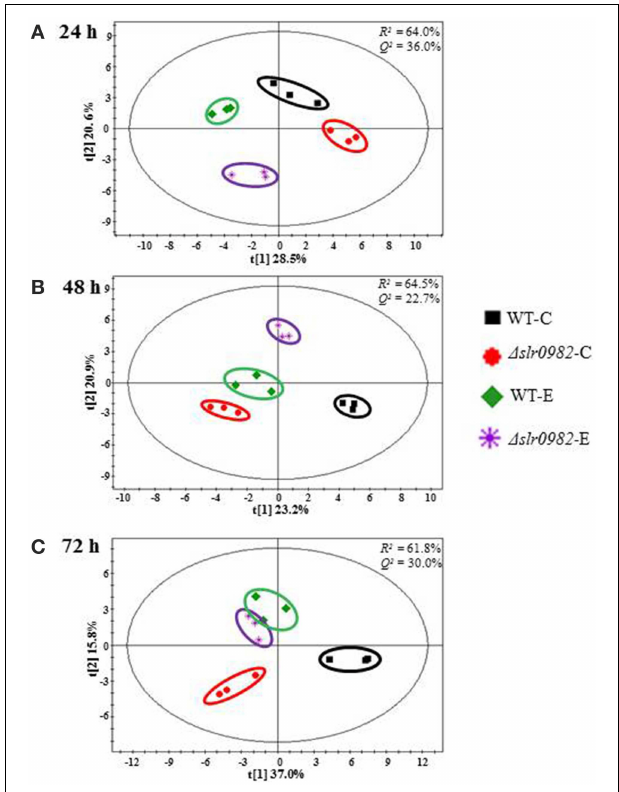
FIGURE 4 | PCA plot analysis of GC-MS metabolomic profiles. (A) 24h; (B) 48h; (C) 72h. Each dot represents one biological sample, while the dots of the same color are biological replicates. Four groups of samples, the wild type and the 1 slr0982 mutant grown in the BG11 media with or without 1.5% ( v / v ) ethanol stress are indicated by different colors, and each group is indicated by a circle. WT-C and WT-E: wild type grown with or without 1.5% ( v/v ) ethanol stress. 1 slr0982 -C and 1 slr0982 -E: the 1 slr0982 mutant grown with or without 1.5% ( v/v ) ethanol